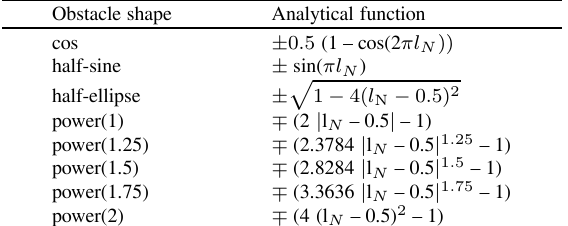
Table 1 Analytical functions h N = f ( l N ) for fi tting the normalised